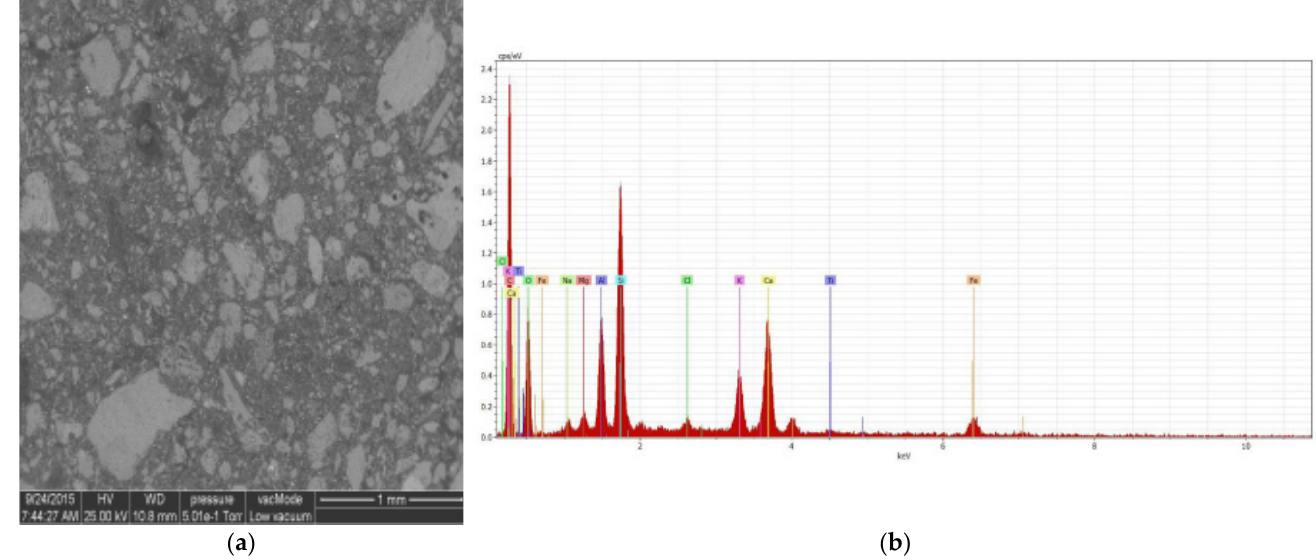
Figure 7. ( a ) Mortar image with Environmental scanning electron microscope (ESEM) modality low vacuum (LV); ( b ) energy dispersive spectroscopy (EDS) analysis on the mortar.